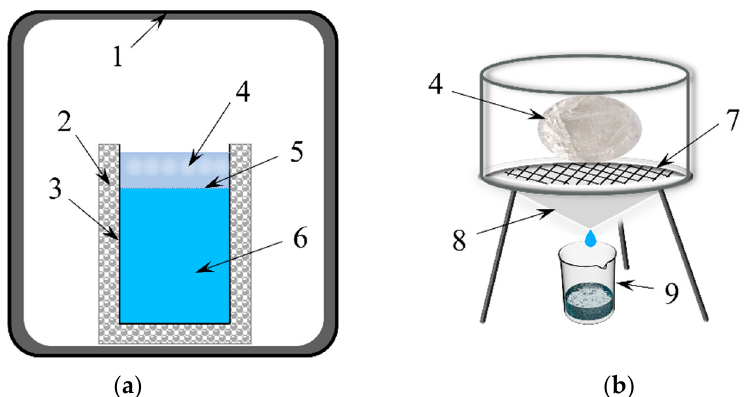
Figure 1. Schematic diagram of the experimental setup. ( a ) Freezing device. ( b ) Ice-melt device. (1 low temperature experiment box; 2 EPS Insulation; 3 cylindrical glass container; 4 ice layer; 5 ice/water interface; 6 water; 7 filter screen; 8 conical funnel; 9 beaker).